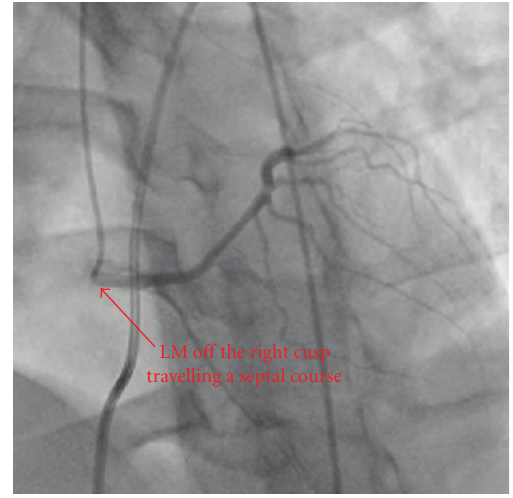
Figure 3: Coronary angiography showing the left main (LM) originating from the right cusp and traveling between the left ventricular outflow tract (LVOT) and the right ventricular outflow tract